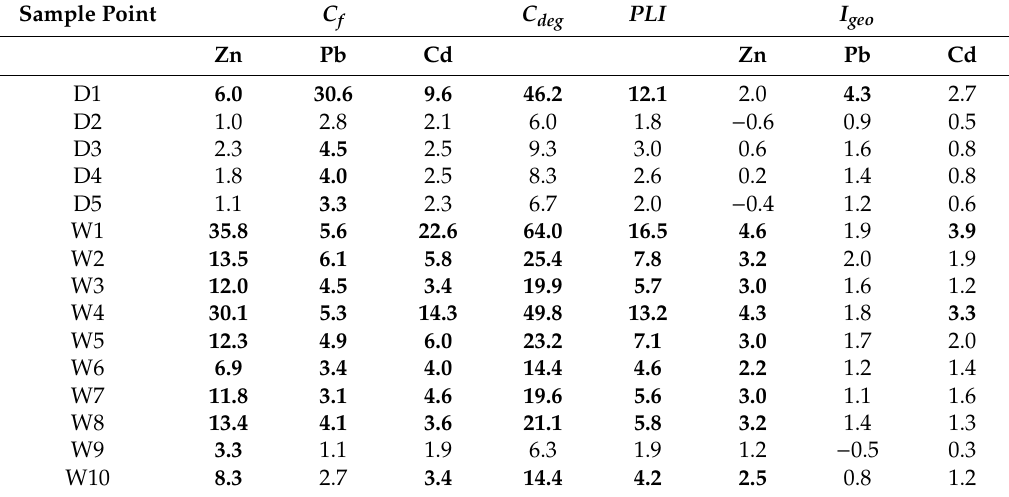
Table 4. Assessment of HM pollution indices in studied topsoil in relation to the local carbonate bedrock in the D-Dlugoszyn and W-Wilkoszyn areas as a background